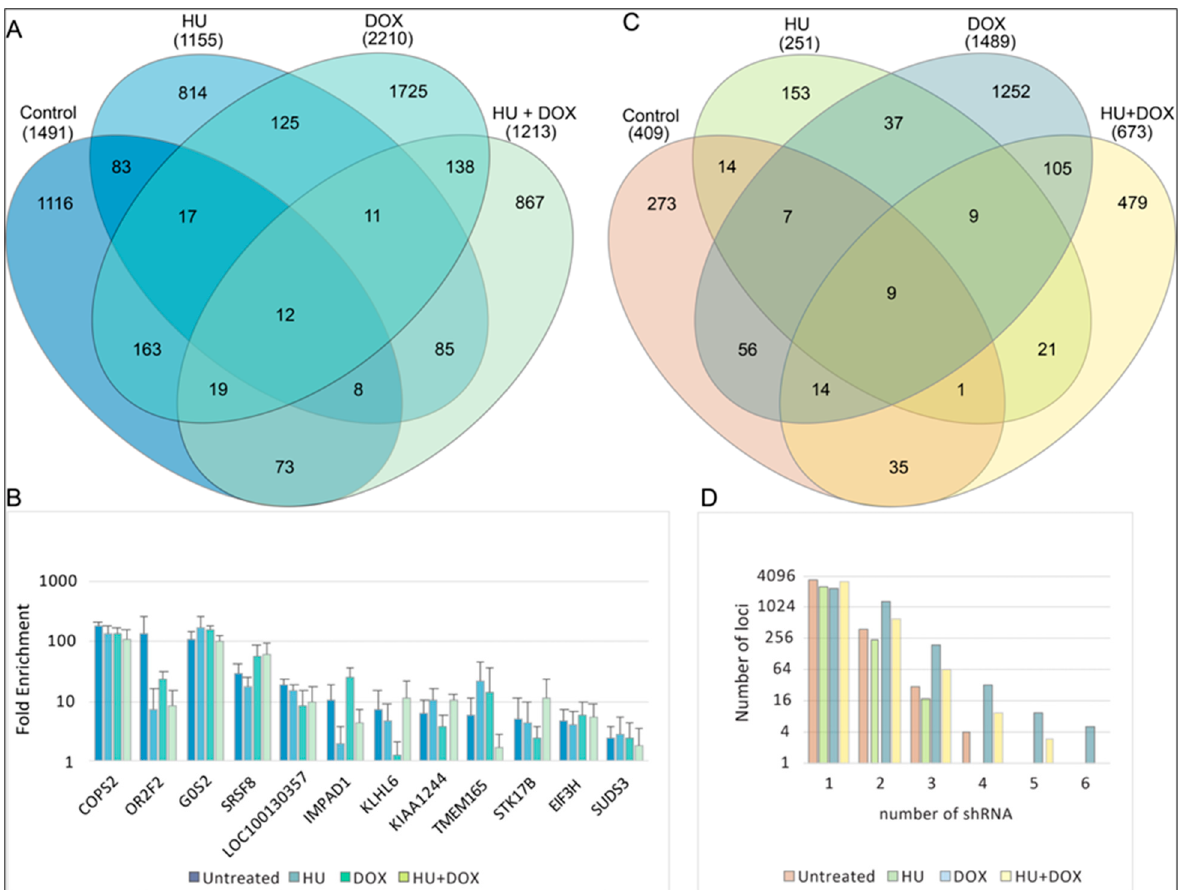
Figure 3. Treatment group comparisons in DF/myc(CTG) 100 eGFP/TK cells. The list of genes targeted by the lentiviral shRNAs was investigated. ( A ) Genes targeted and identified with a false discovery rate (FDR) = 0.001 [58,59] (see also Supplementary Tables S2 and S3). ( B ) Enrichment levels based on the sequence read counts before and after selection for the 12 genes found to be common to all treatments. ( C ) Genes targeted by two or more different shRNAs in a given treatment (see also Supplementary Table S4). ( D ) Number of loci with one or more shRNAs targeting each locus within each treatment category.